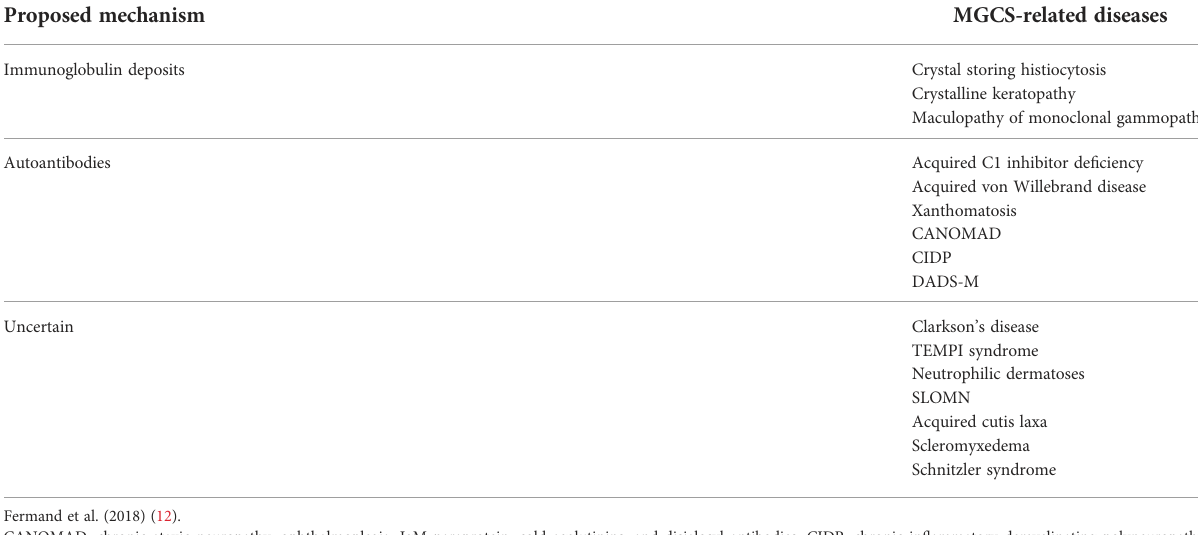
TABLE 1 Potential mechanisms of MGCS-related